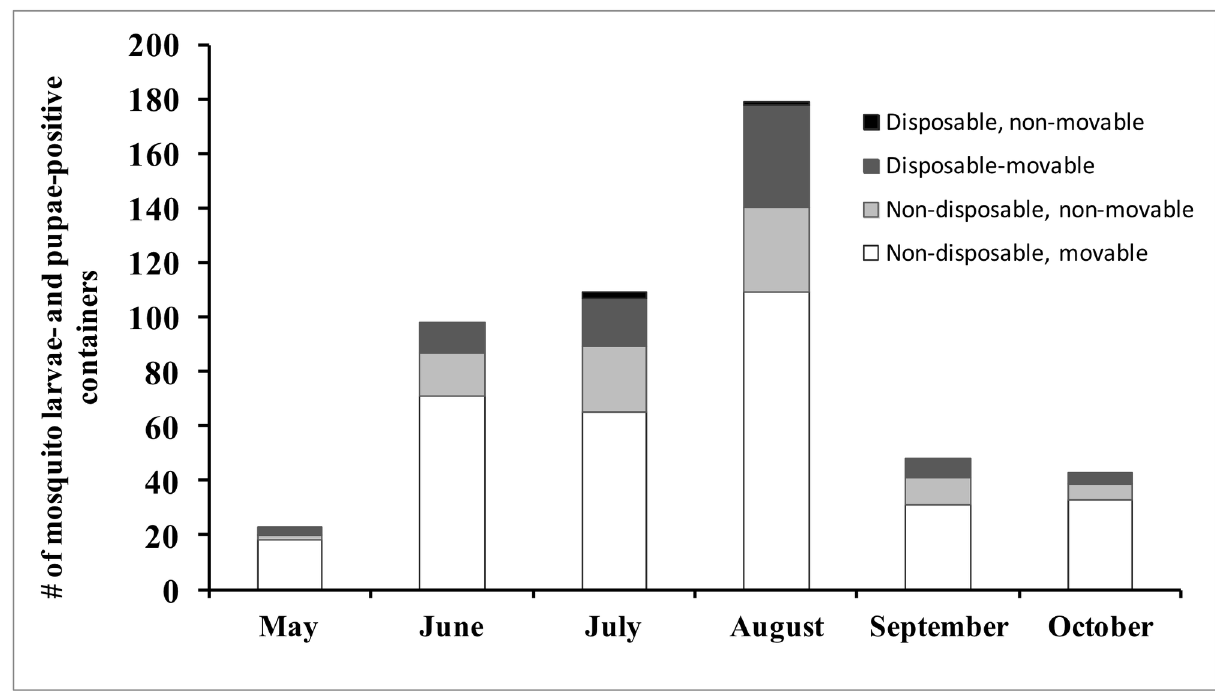
Figure 2. Number of wet containers and container type examined each month (May-October) in the study site during larval surveys in 2009. Containers were classified as “disposable” if intended for one-time use, “non-disposable” if intended for long-time term or repeated use, “movable” if easily displaced by an average adult and “non-movable” if otherwise. doi: